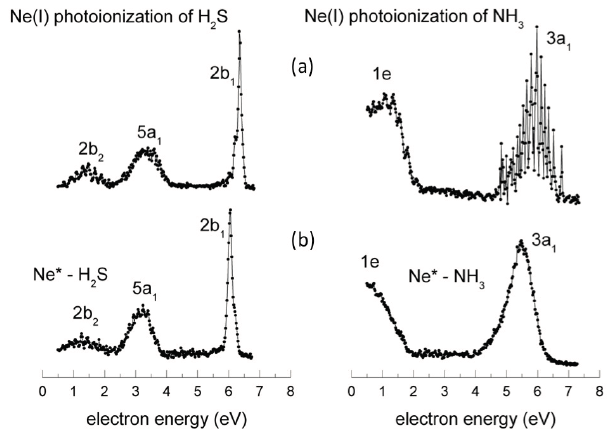
Figure 5. The obtained ( a ) PES (upper panel) and ( b ) PIES (lower panel) spectra in photoionization and Penning ionization studies of hydrogen sulfide (left side) and ammonia (right side) molecules by using Ne(I) photons and Ne * ( 3 P 2,0 ) metastable atoms, respectively. By looking at the relative position of the corresponding peak maxima in the PES and PIES spectra for both investigated systems, it is possible to measure the negative energy shifts ( − 80 meV and − 120 meV for 2b 1 and 5a 1 electronic states of H 2 S + , respectively; and − 290 meV and − 140 meV for 3a 1 and 1e electronic states of NH 3+ ), with the same procedure used in the Ne * -H 2 O case (see Figure 2 and the